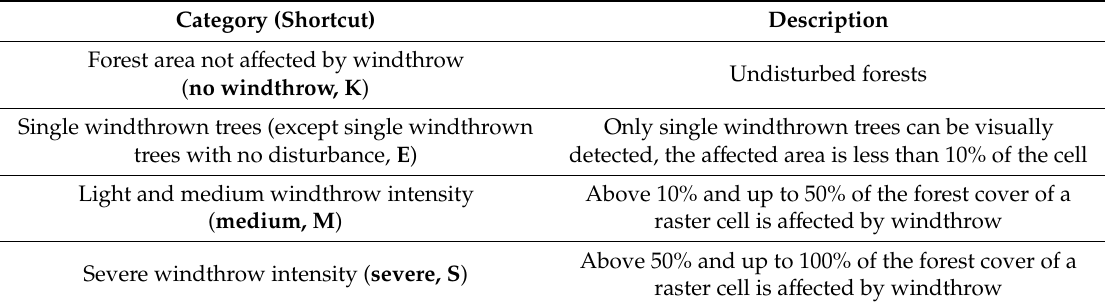
Table 2. Categories of windthrow intensities used in this